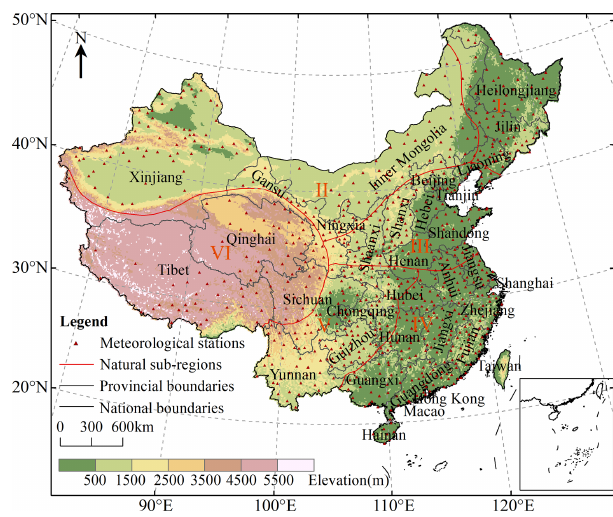
Figure 1. Overview of the study